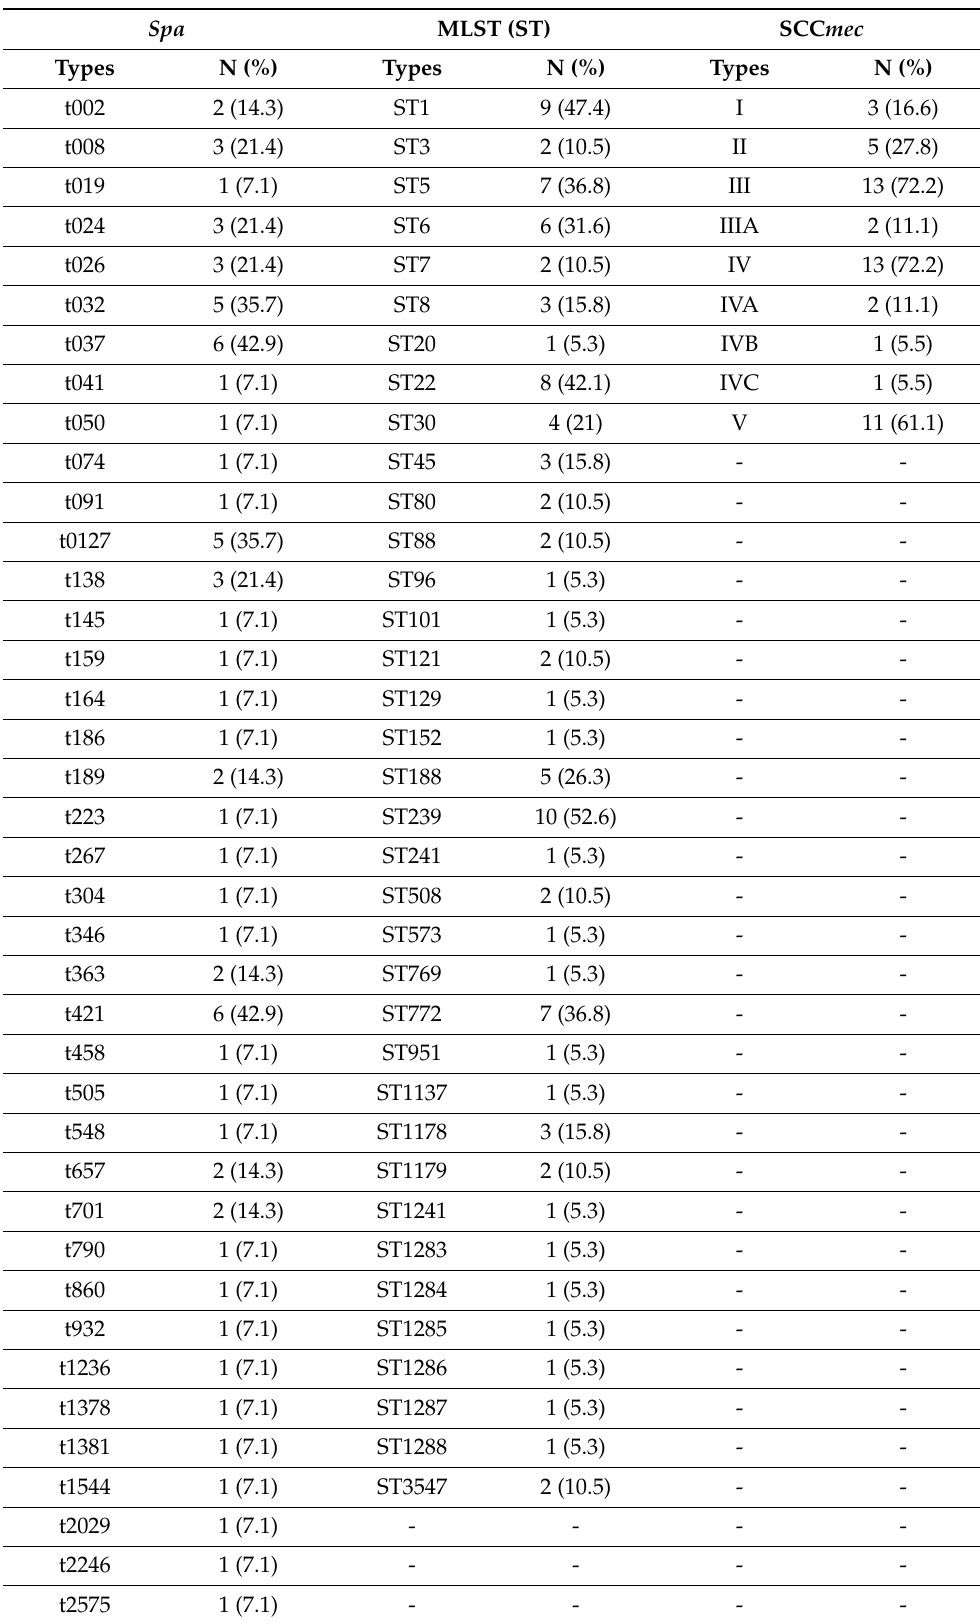
Table 2. Frequencies of multilocus sequence typing (MLST) and staphylococcal protein A (spa)